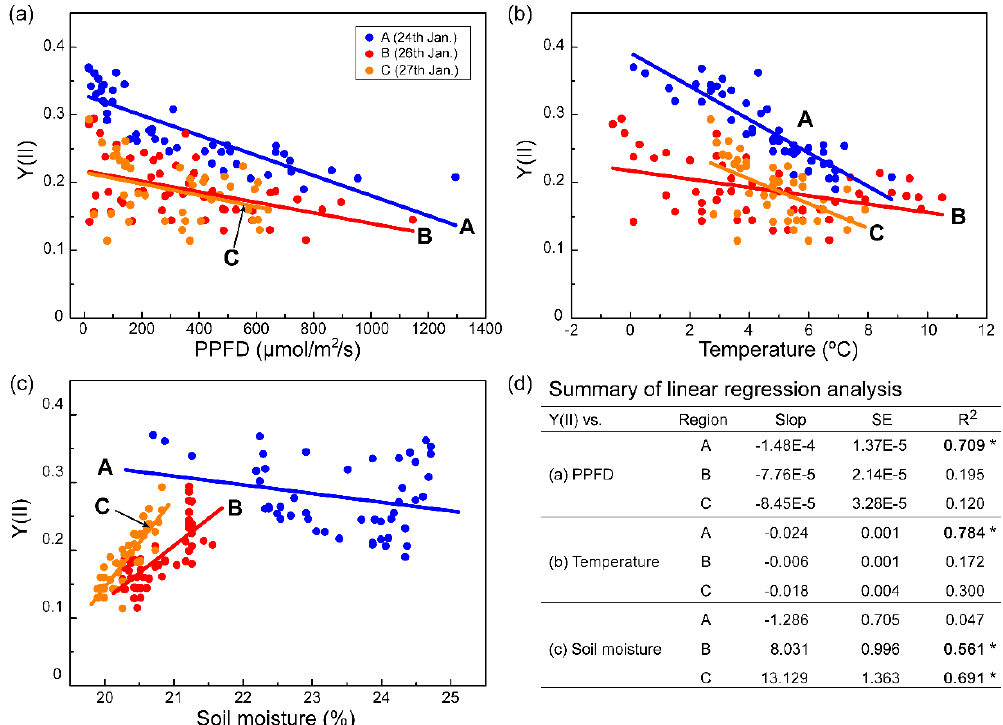
Figure 3. Correlation between Y(II) of C. borealis and PPFD ( a ), temperature ( b ), and volumetric soil moisture ( c ) parameters. Data were extracted from Regions A, B, and C in Figure 2b. A fitting analysis for linear regression was performed for each dataset. ( d ) The linear regression parameters are presented in a tabular format. Asterisks indicate R 2 > 0.5. SE, standard error.